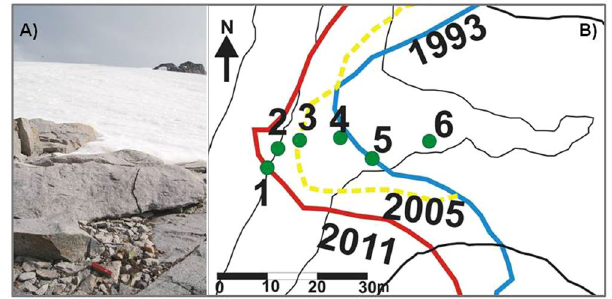
Figure 1. ( A ) View of the glacial margin of the Wormald Ice Piedmont (Rothera Point, Antarctic Peninsula, taken in 2009). The occurrence of exhumed patches of the moss Bryum pseudotriquetrum can be seen in the foreground. ( B ) Map showing the location of the moss samples (see Table 1) with the position of the glacier boundary in 1993 (blue line), 2005 (yellow line) and 2011 (red line) (map created by CorelDraw